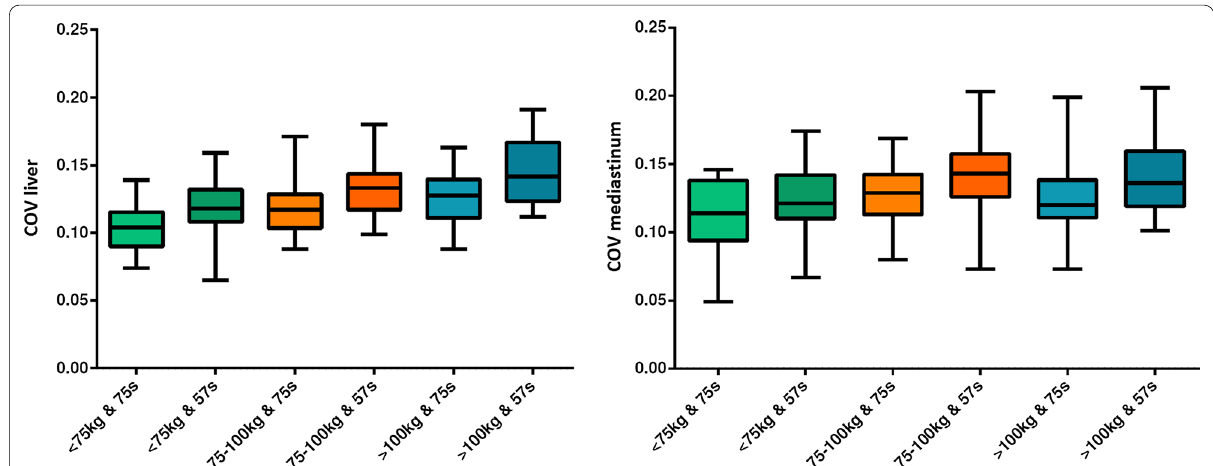
Fig. 7 Boxplots representing COV liver and COV mediastinum for different bw classes ‑ 75 s and 57 s PET/CT acquisition time